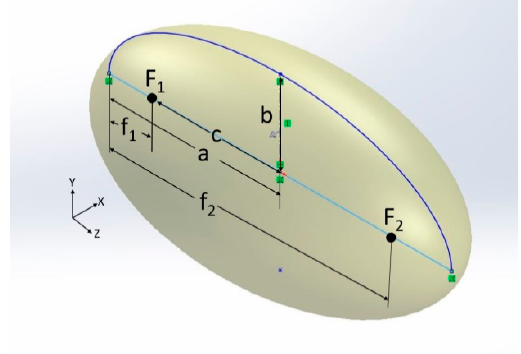
Figure 2. Schematic of the ellipsoid.